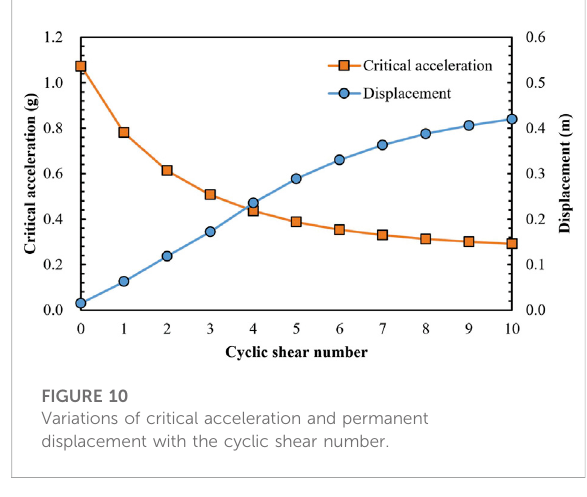
FIGURE 10 Variations of critical acceleration and permanent displacement with the cyclic shear